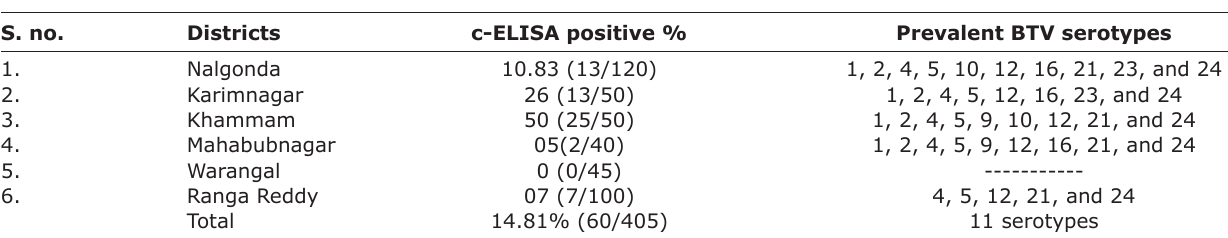
Table-1: Type-specific seroprevalence of BTV. S. no.